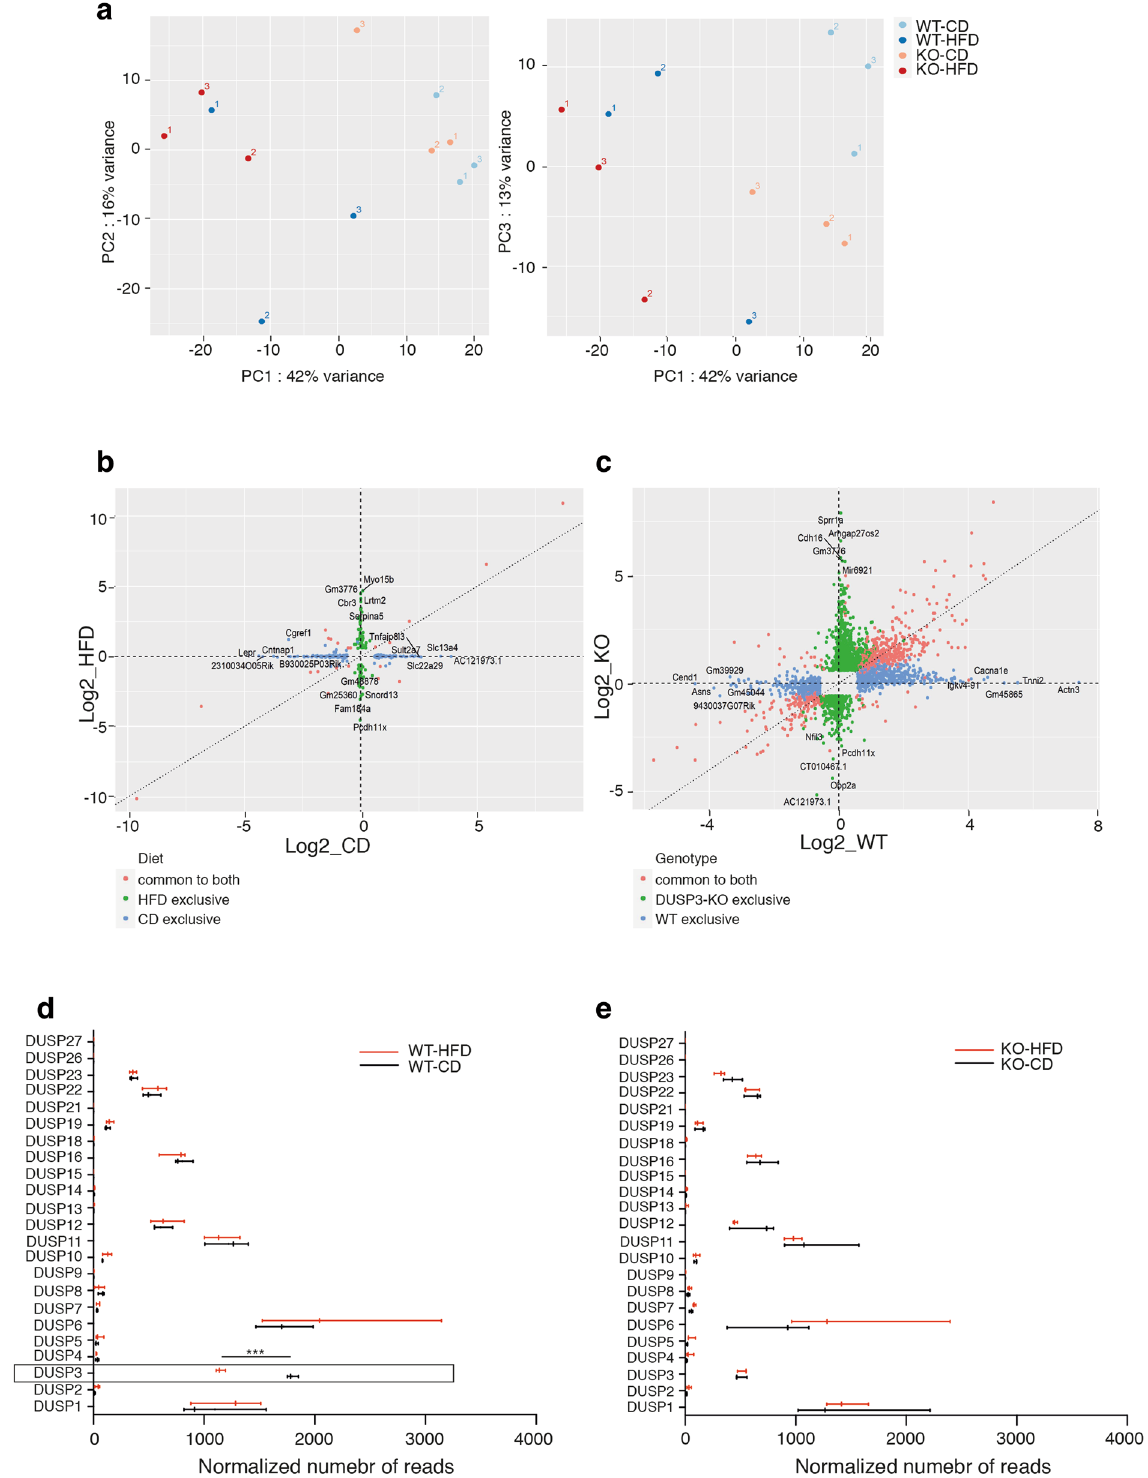
Figure 8. RNAseq analysis of DUSP3-KO and WT mice livers under CD and HFD. ( a ) Principal component analysis (PCA) on DUSP3-KO mice livers under CD (orange dots), or HFD (red dots) and WT mice livers under CD (light blue dots) or HFD (dark blue dots). ( b , c ) Comparison of the fold change difference between WT and DUSP3-KO genotypes for CD and HFD ( b ) and between CD and HFD for WT and the DUSP3-KO ( c ). Genes with adjusted p-value < 0.05 and fold change > 1.5 in at least one genotype were plotted. ( b ) Genes exclusive to CD are blue, the ones exclusive to HFD are green and the ones in common to both are red. ( c ) Genes exclusive to WT are blue, the ones exclusive to DUSP3-KO are green and the ones in common to both are red. Genes with the 5 highest or lowest fold changes in each group are labeled. ( d , e ) Comparison of expression levels of all known DUSPs in WT and DUSP3-KO (KO) mice under CD and HFD. Data are shown as normalized number of reads for each individual gene. ***P <